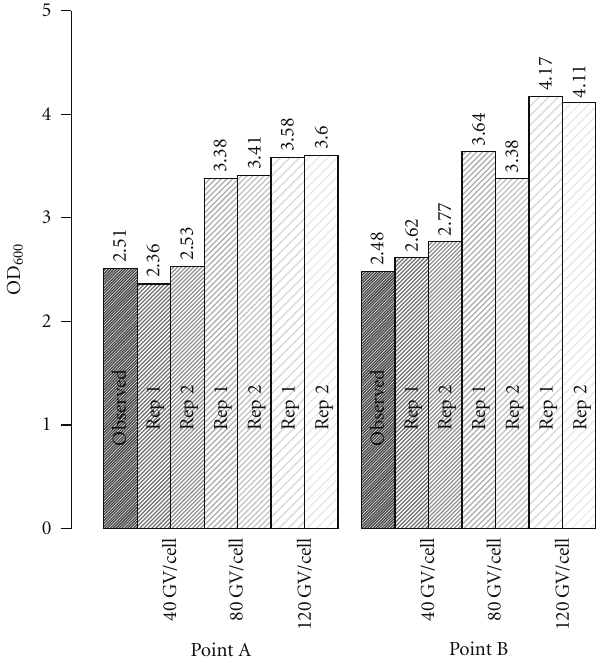
Figure 2: The contribution of free gas vesicles to light scattering at 600 nm. Gas vesicles were purified as described in Materials and Methods. To replicate the concentration of viable cells at points a and b (Figure 1) cells grown to OD 600 = 0 . 4 were concentrated to OD 600 = 1 . 0 and OD 600 = 0 . 5, respectively. These OD 600 represent a baseline of scattering form lightly-vacuolated/non-lysed cells at equivalent CFUs to points a and b in Figure 1. Purified gas vesicles were added to concentrated cells in amounts corresponding to the product of either 40, 80, 120GV/cell and the total number of cells that were expected to have lysed between points x and a, and x and b. OD 600 of the cell/GV mixtures was remeasured. Observed OD 600 values from Figure 1 (points A and B), in addition to mixture OD 600 are plotted as bar charts. OD 600 values are included above each